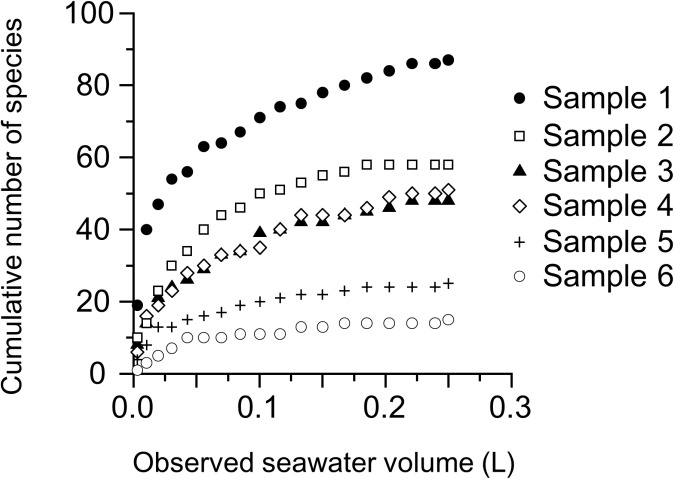
Species accumulation curves of 6 samples obtained during the KH12-3 cruise (see Fig 1).Sample information is provided as follows: sample 1: 5 m, 28°00’ N, 138°00’ E; sample 2: 75 m, 32°19’ N, 133°33’ E; sample 3: 43 m, 33°05’ N, 133°40’ E; sample 4: 75 m, 35°00’ N, 160°00’ E; sample 5: 5 m, 43°31’ N, 160°00’ E; sample 2: 75 m, 15°00’ N, 160°00’ E.